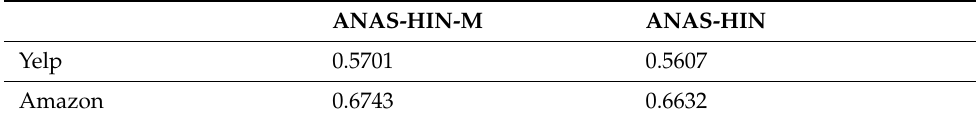
Table 4. Experimental results of ablation